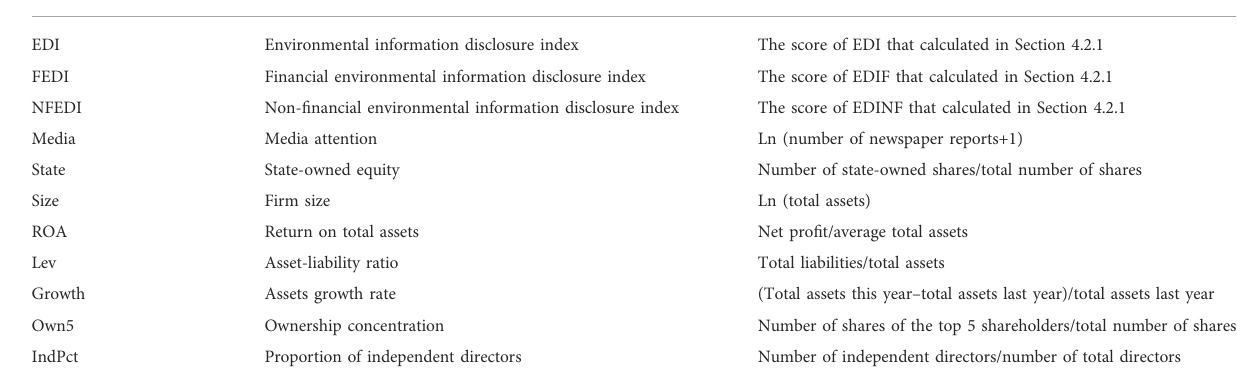
TABLE 2 Variable de fi nition.